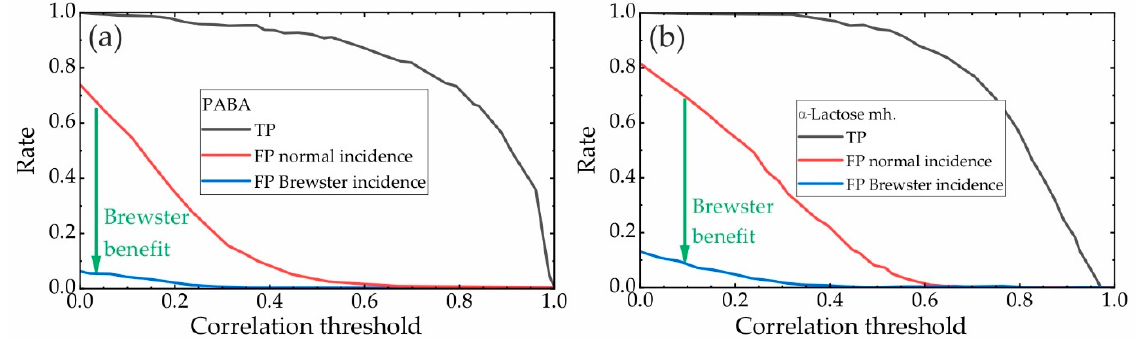
Figure 10. Improvement of false positive rates (FP) when using an incidence of the terahertz radiation at the Brewster’s angle compared to normal incidence for the two simulants PABA ( a ) and α -Lactose monohydrate (mh.) ( b ). TP: true positive rate.